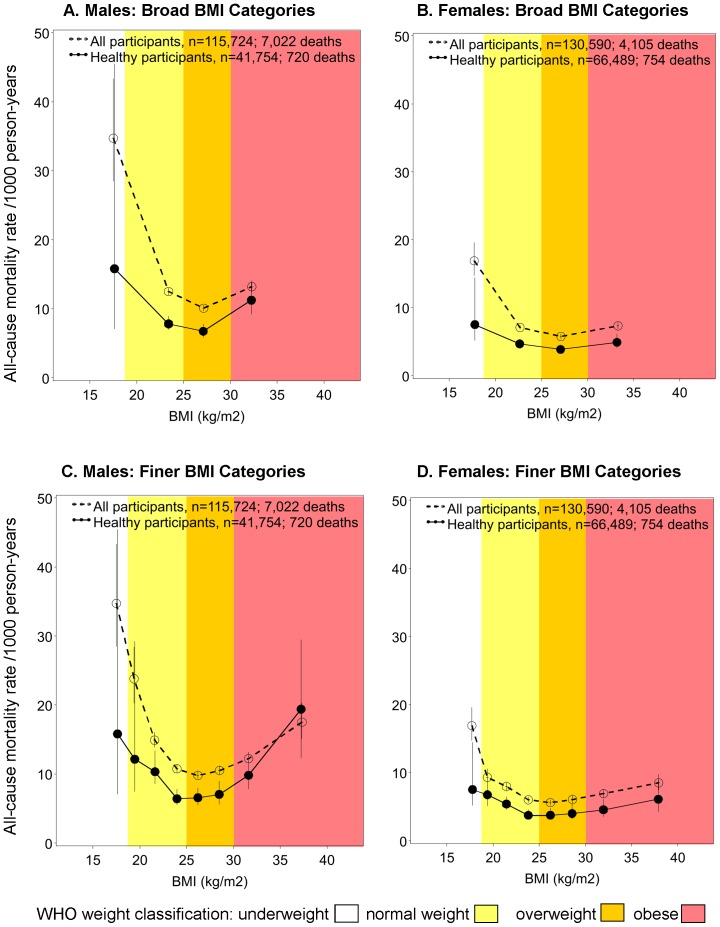
All-cause mortality rates (95% CI) per 1000 person-years by sex and differing BMI categories, directly age-standardised to 2006 New South Wales population.Rates plotted at median body mass index (BMI) for the categories: broad categorisation 15–18.49, 18.5–24.99, 25–29.99, 30–50 kg/m2; finer categorisation 15–18.49, 18.5–19.99, 20–22.49, 22.5–24.99, 25–27.49, 27.5–29.99, 30–34.99, 35–50 kg/m2. The healthy participants analysis excludes those who ever smoked at baseline, those with a history of CVD at baseline (defined as self-reported heart disease, stroke or blood clot on the baseline questionnaire) and those with a history of cancer at baseline (defined as self-reported history of cancer other than melanoma and skin cancer on the baseline questionnaire), and excludes the first 2 years of follow-up.